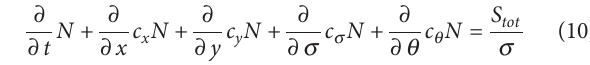
term shows the variation of wave action density in q space by refraction and shallower action caused by water depth and fl ow.